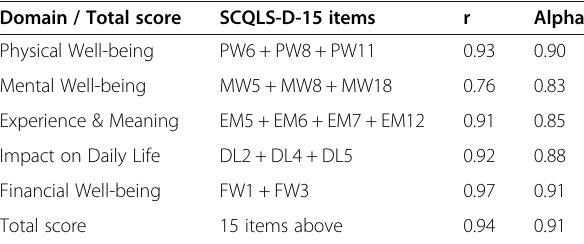
Table 5 Measurement properties of the 15-item short form of the Singapore Caregiver Quality of Life Scale – Dementia (SCQOLS-D-15) in the follow-up